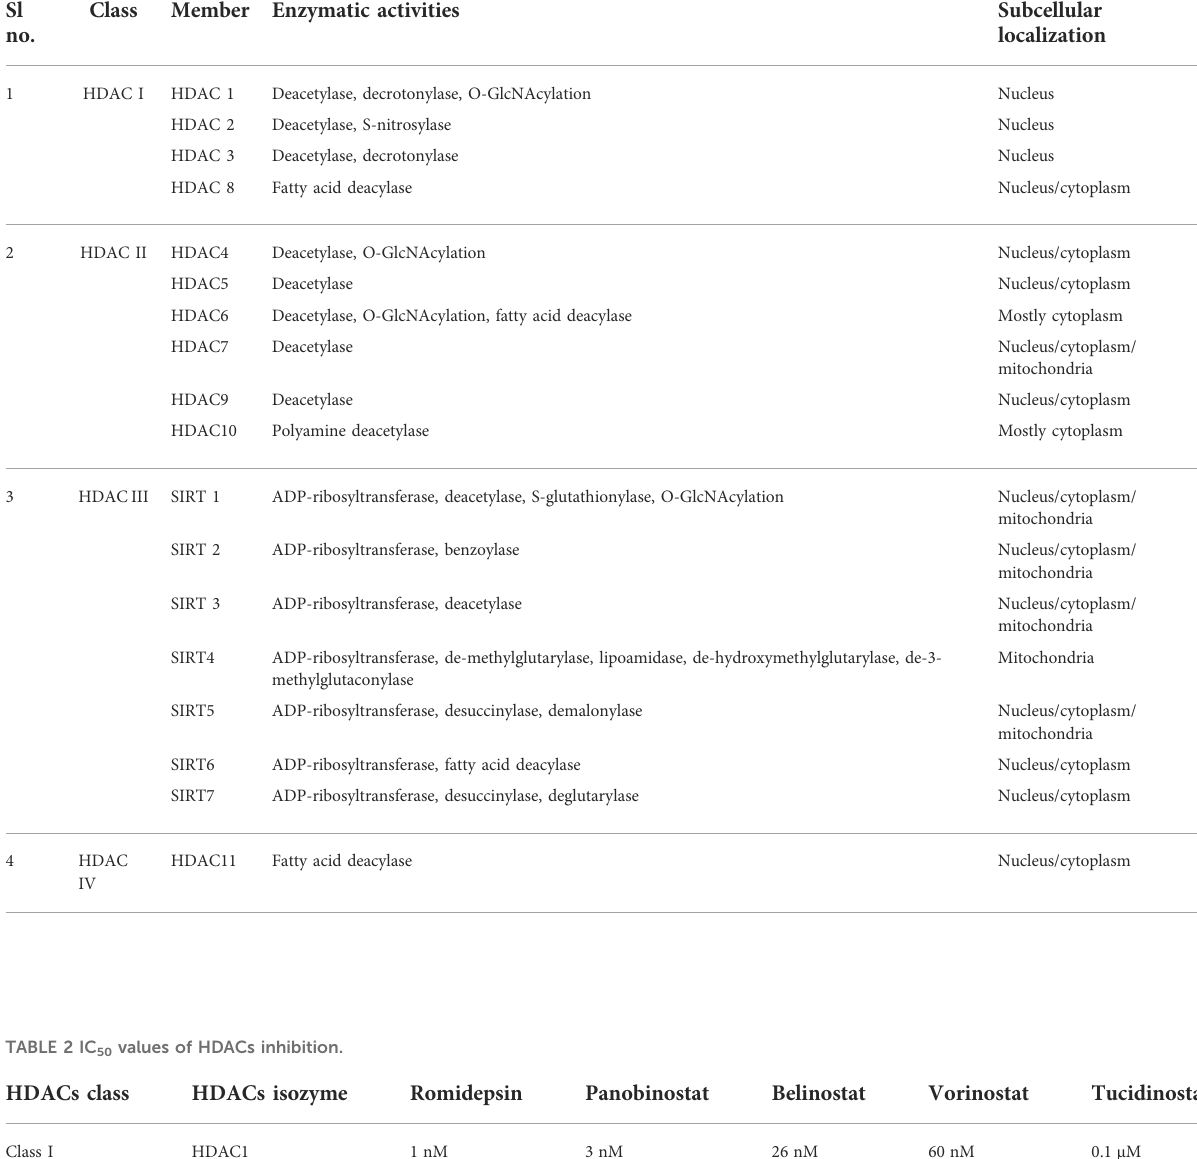
TABLE 1 Classi fi cation of HDACs.